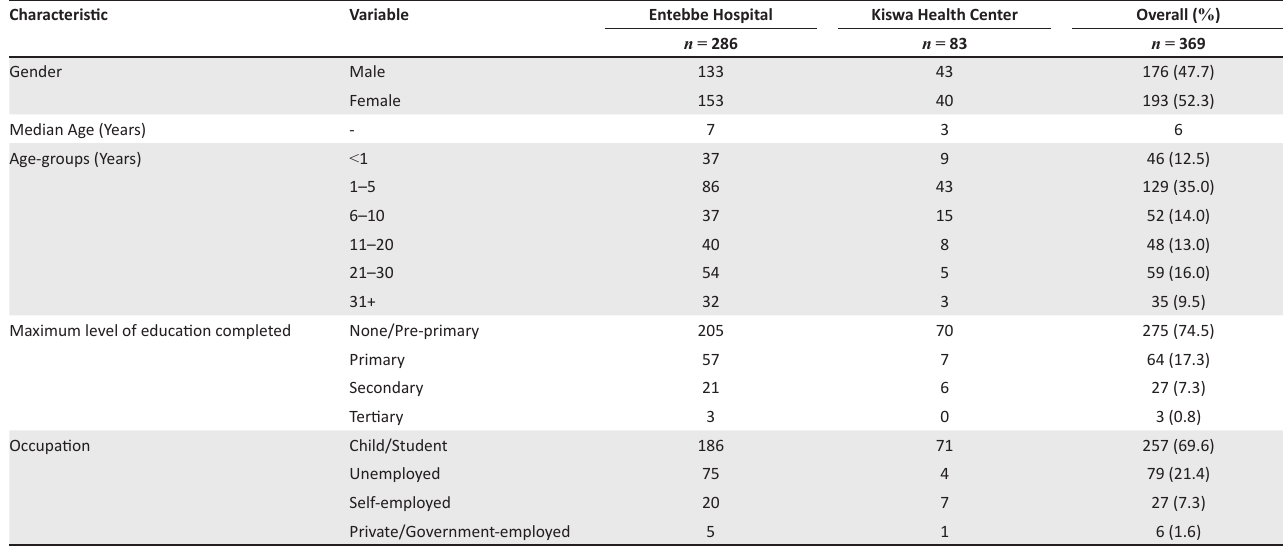
TABLE 1: Demographic characteristics of patients with influenza-like illness at Kiswa Health Center and Entebbe Hospital, Uganda, between August 2008 and December 2008. Characteristic